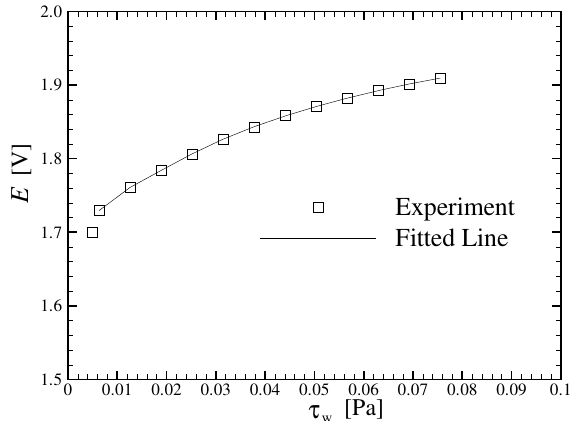
Fig. 7 Static response of HF sensor with rotating cylinder ( (cid:28) w versus E ).